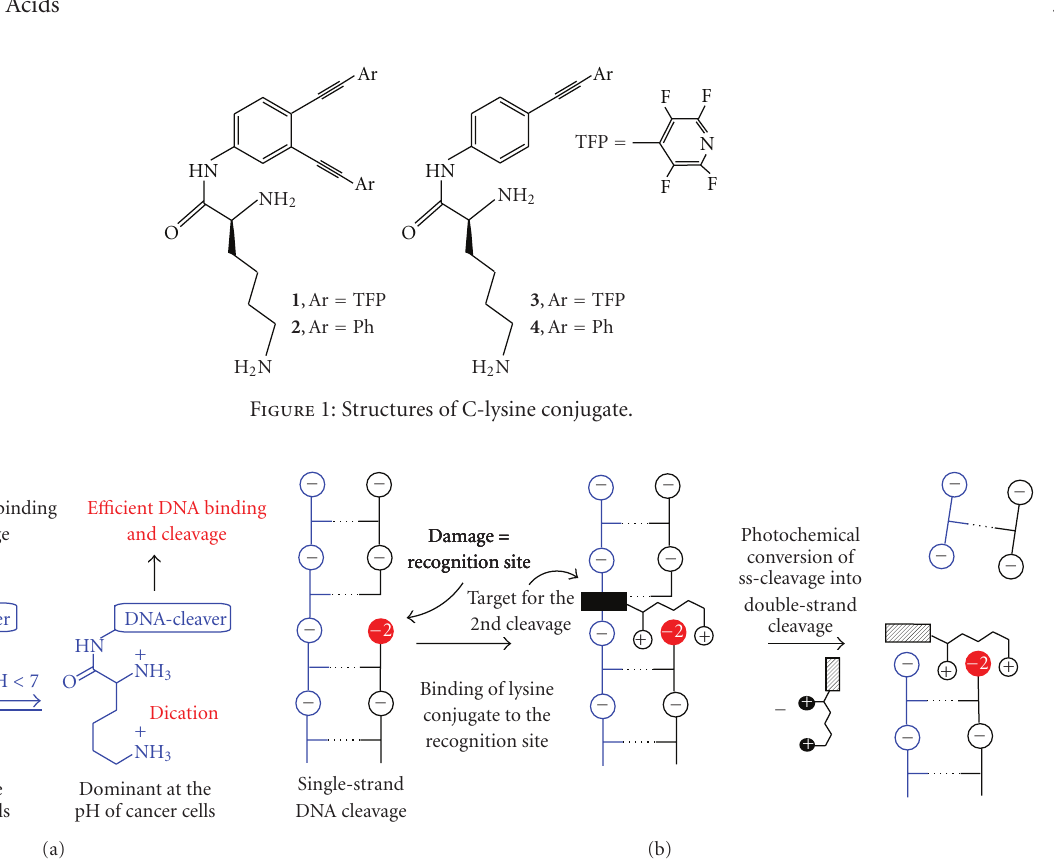
Figure 2: (a) Design of pH-dependent DNA-cleavers based on di ff erent stages of protonation of the lysine side chain, (b) photochemical conversion of ss-DNA cleavage into more therapeutically important ds-DNA cleavage through lysine-phosphate monoester recognition of the initial damage